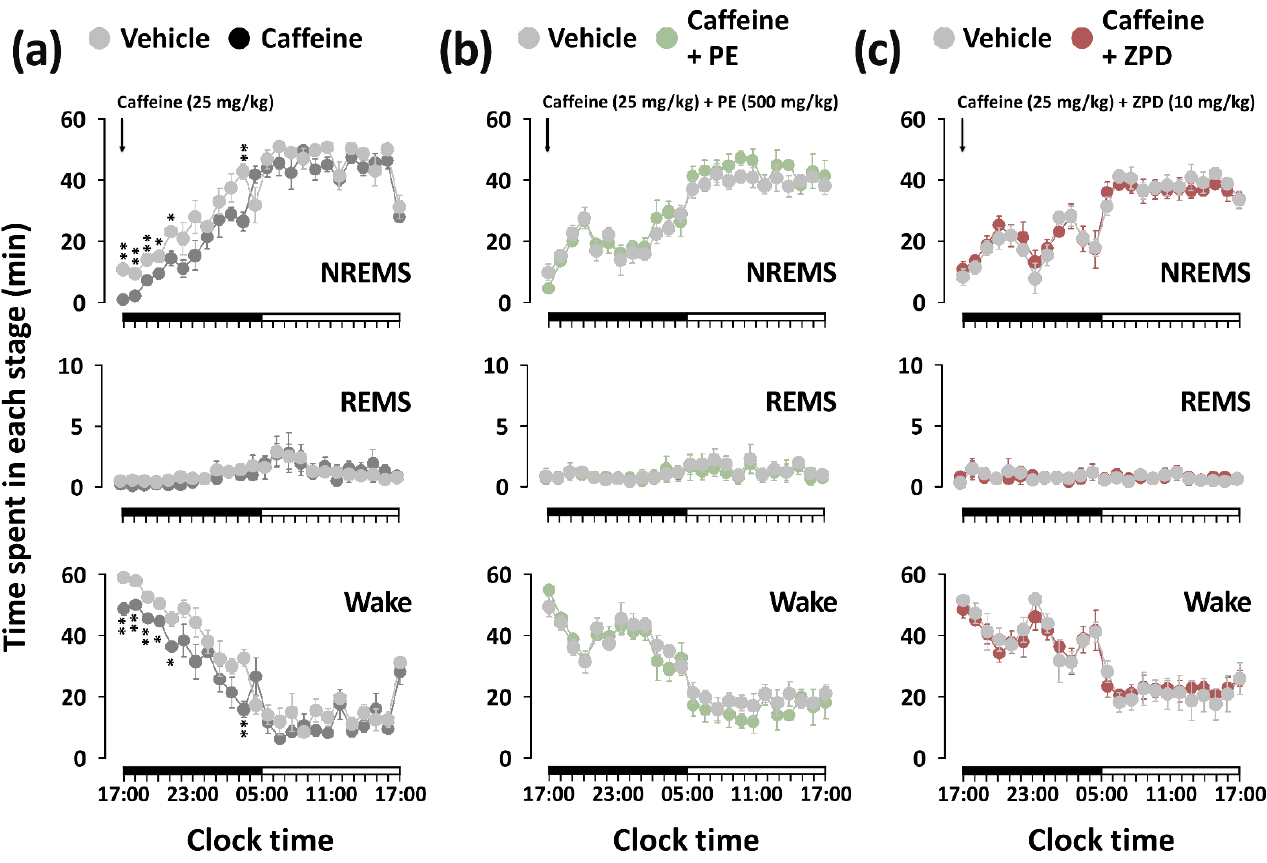
Figure 4. Temporal changes in NREMS, REMS, and Wake for 24 h after oral administration of caffeine alone ( a ), caffeine + PE ( b ), or caffeine + ZPD ( c ) to C57BL/6N mice. Each circle represents the hourly mean ± SEM amount of each stage ( n = 7–8 per group). * p < 0.05 and ** p < 0.01, significantly different from the vehicle control (paired Student’s t -test).